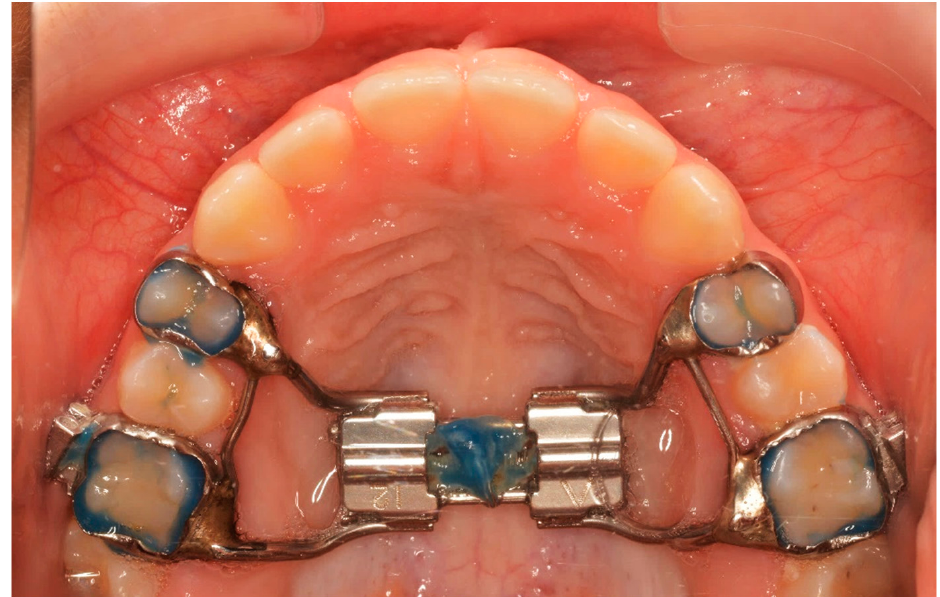
Figure 1. The end of the active phase of expansion.